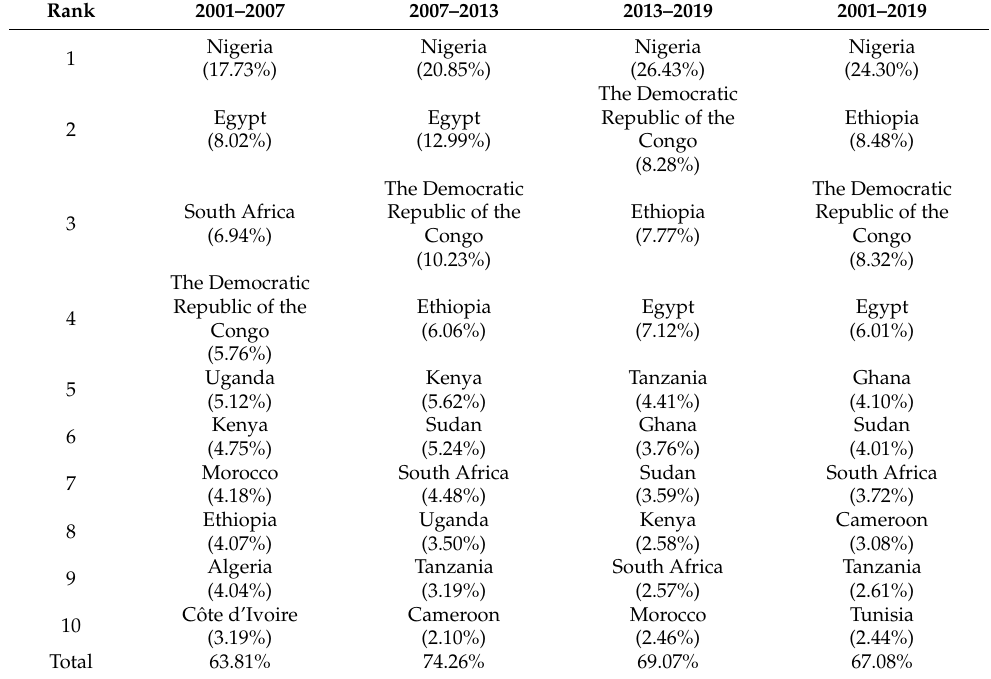
Figure 10. Spatial changes of the urban population in different periods. Table 3. Ten major African countries and their share of urban land growth in different Table 4. Ten major African countries and their share of urban population growth in different peri- ods.